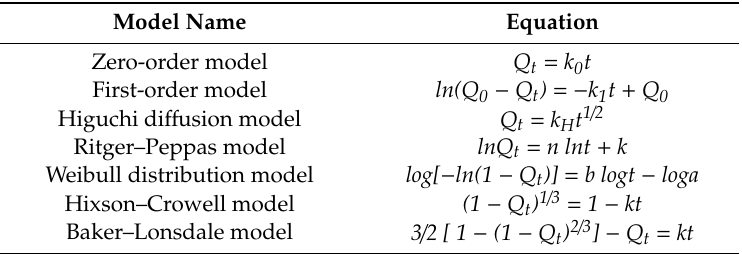
Table 3. Models for drug